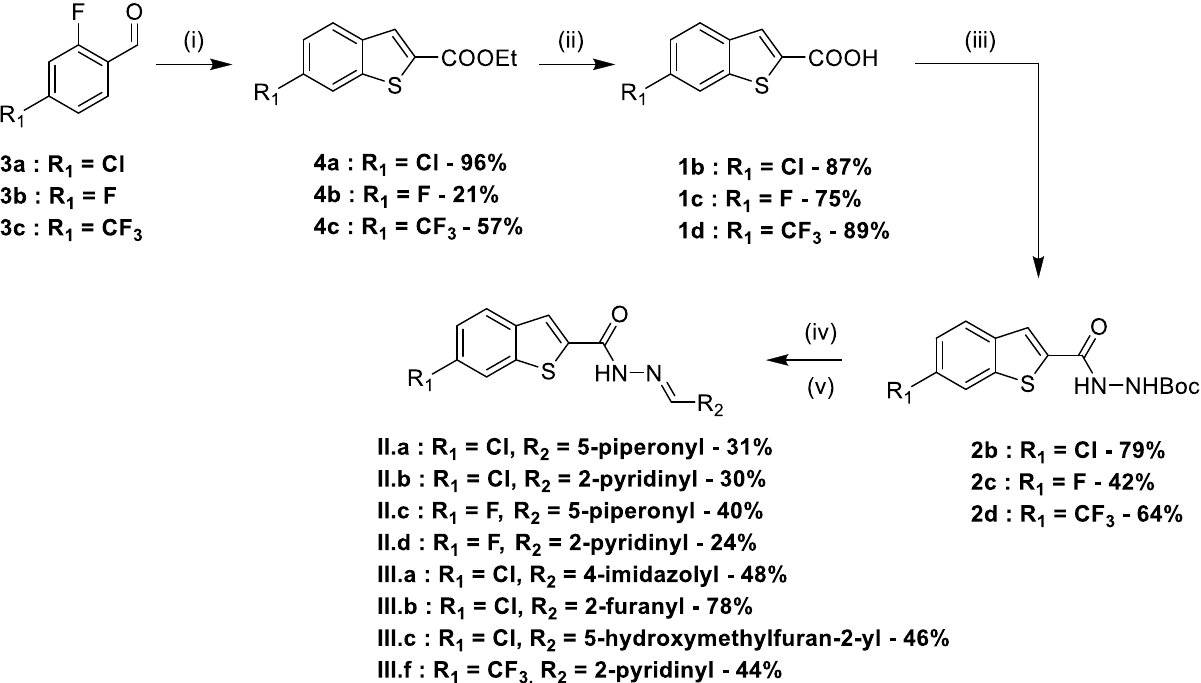
Table 2. Minimum inhibitory concentrations of set II molecules against S. aureus